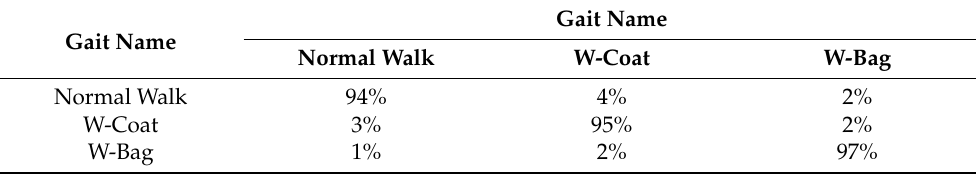
Table 5. Confusion matrix of OaA-SVM for CASIA B dataset.